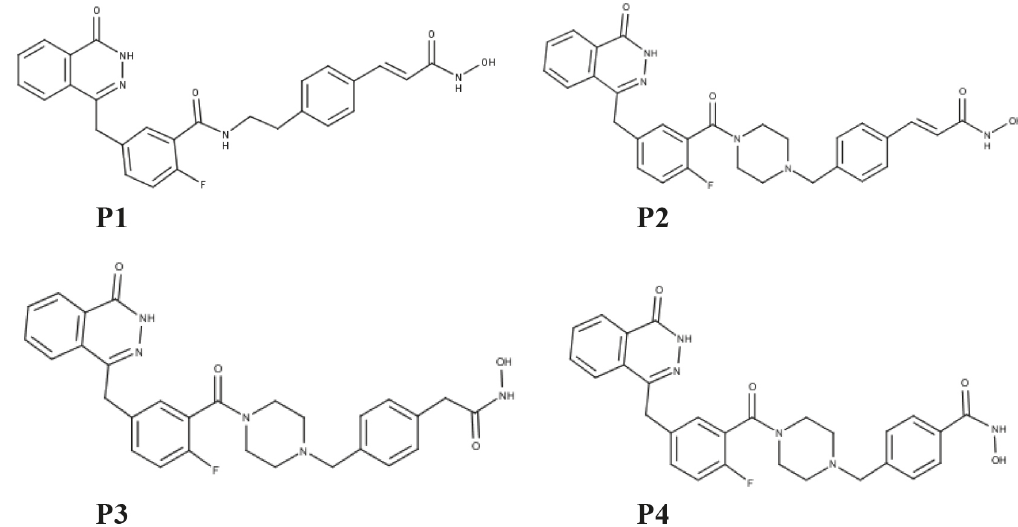
FIGURE 32 - Synthesis of designed dual PARP and HDAC inhibitors